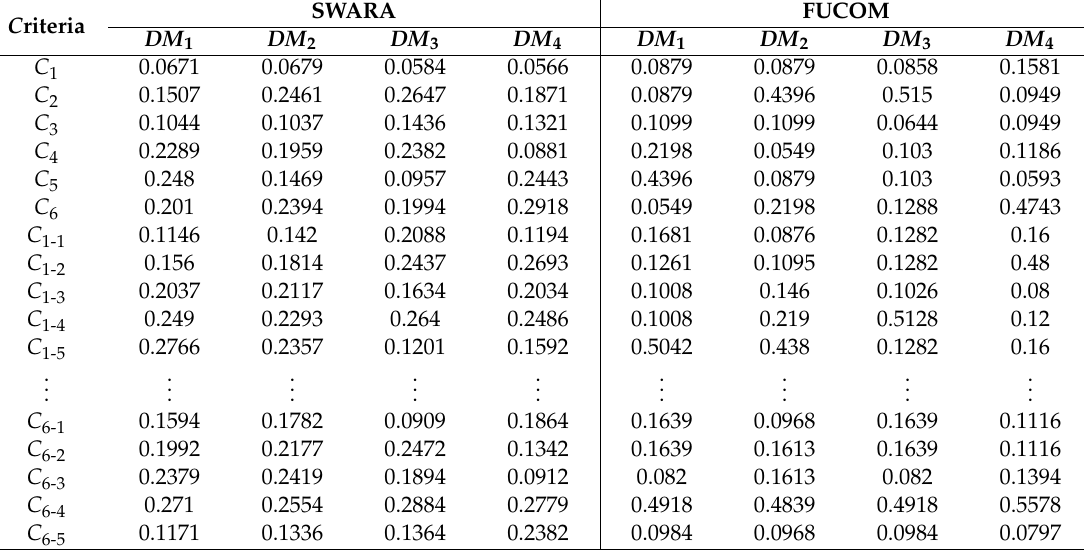
Table 4. Computed SWARA and full consistent method (FUCOM) weights for each